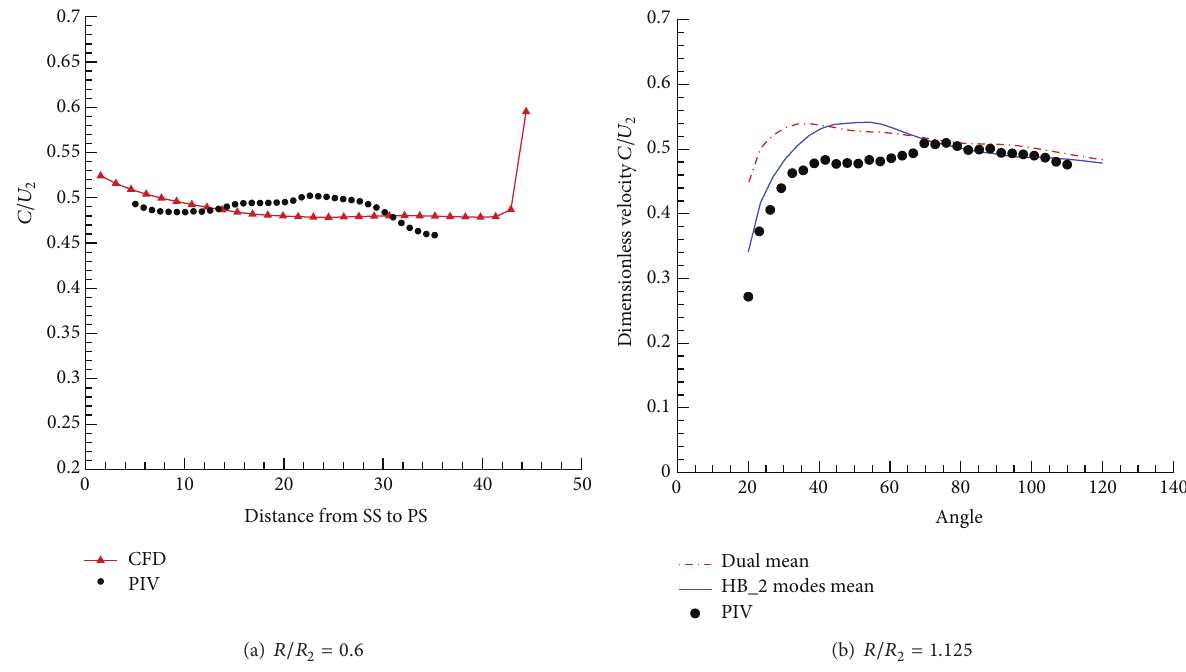
Figure 8: Dimensionless absolute velocity 𝐶/𝑈 2 at the design